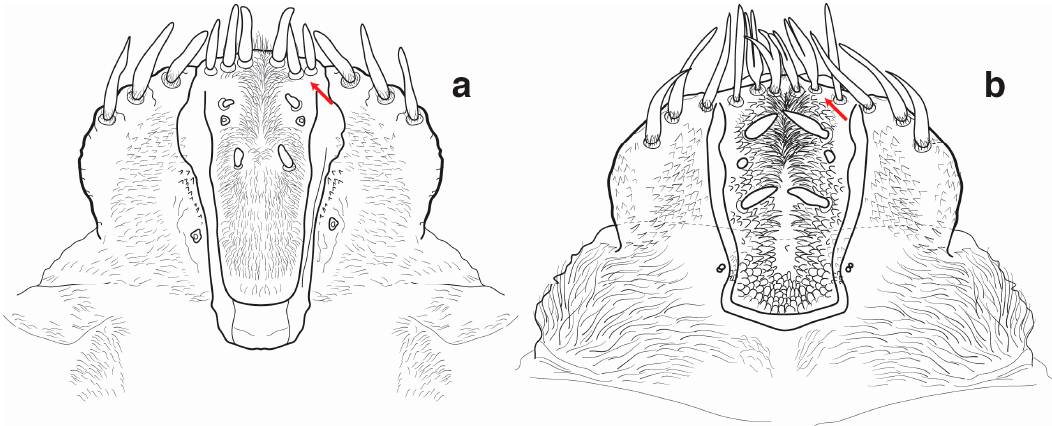
Figure 32. Epipharynx, larva: ( a ) Sphenophorus maidis ; and ( b ) Nassophasis . 19. Shape of mes3 apically (Figure 33)